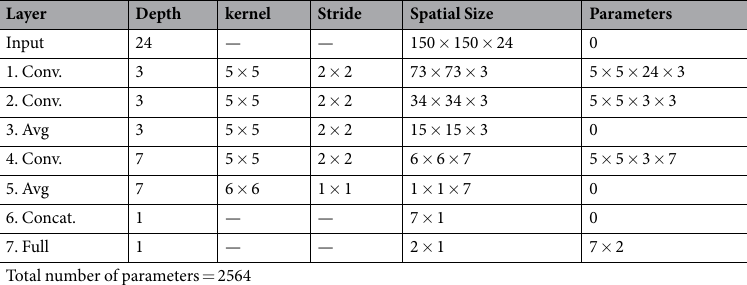
Table 1. The proposed CNN